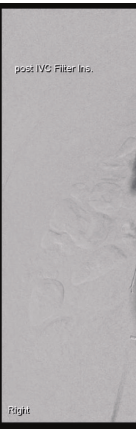
Figure 2: Venogram showing IVC filter.